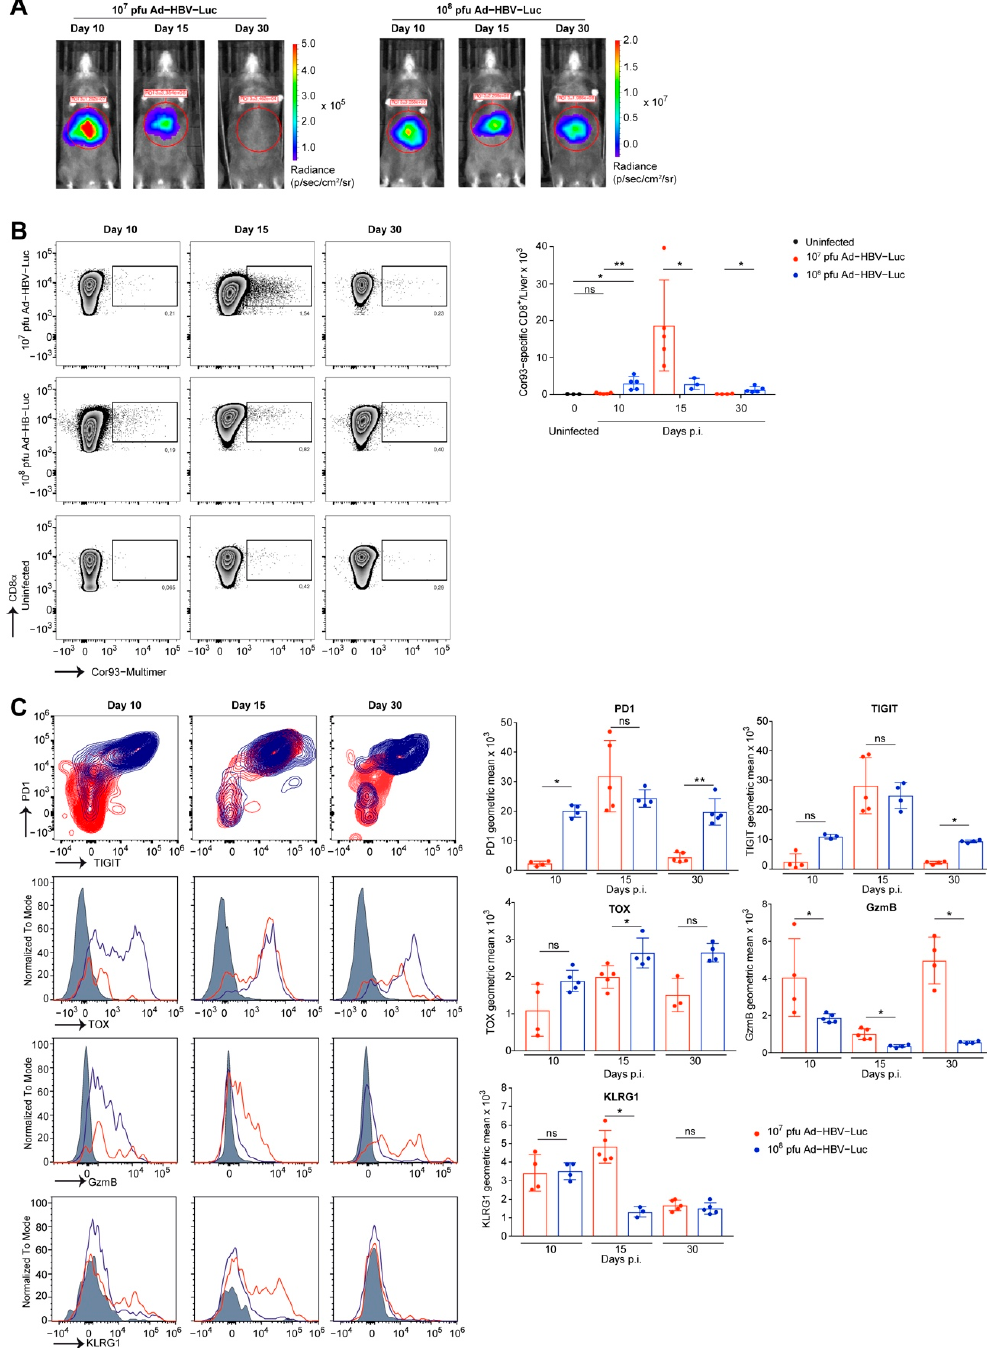
Figure 3. Quantity and phenotype of endogenous intrahepatic HBV-specific CD8 T cells. ( A – C ) Lymphocytes were isolated from livers of C57Bl/6 mice infected i.v. with the acute self-limited (10 7 pfu, red) or chronic infectious dose (10 8 pfu, blue) of Ad-HBV-Luc at indicated time points after infection and analyzed by flow cytometry. ( A ) Representative bioluminescence images of infected mice representing virus-infected hepatocytes. ( B ) Representative FACS plots and quantification of intrahepatic endogenous Cor93-specific CD8 T cells. Quantification in livers of uninfected mice serves as a control for unspecific staining. ( C ) Representative plots/histograms and quantification of indicated marker expression on/in Cor93- specific CD8 T cells (gated on living Cor93-specific CD8 T cells) by geometric mean. Mean and SD are shown ( n = 3–5). The experiments were performed three times